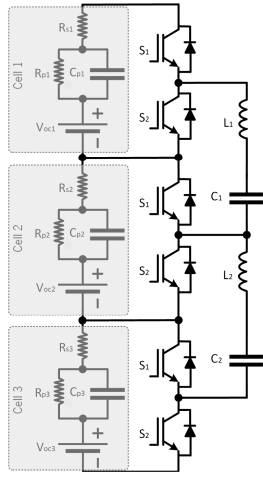
Figure 7. Switched capacitor–inductor converter.